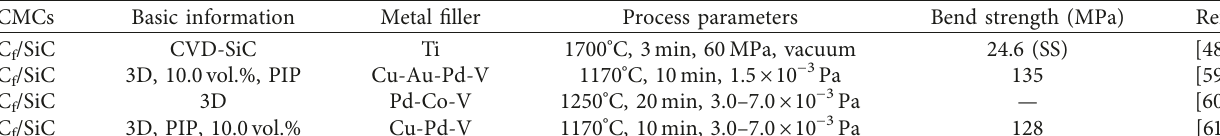
Table 3: Self-joining of C f /SiC composites using metal filler (SS (cid:29) shear strength). CMCs